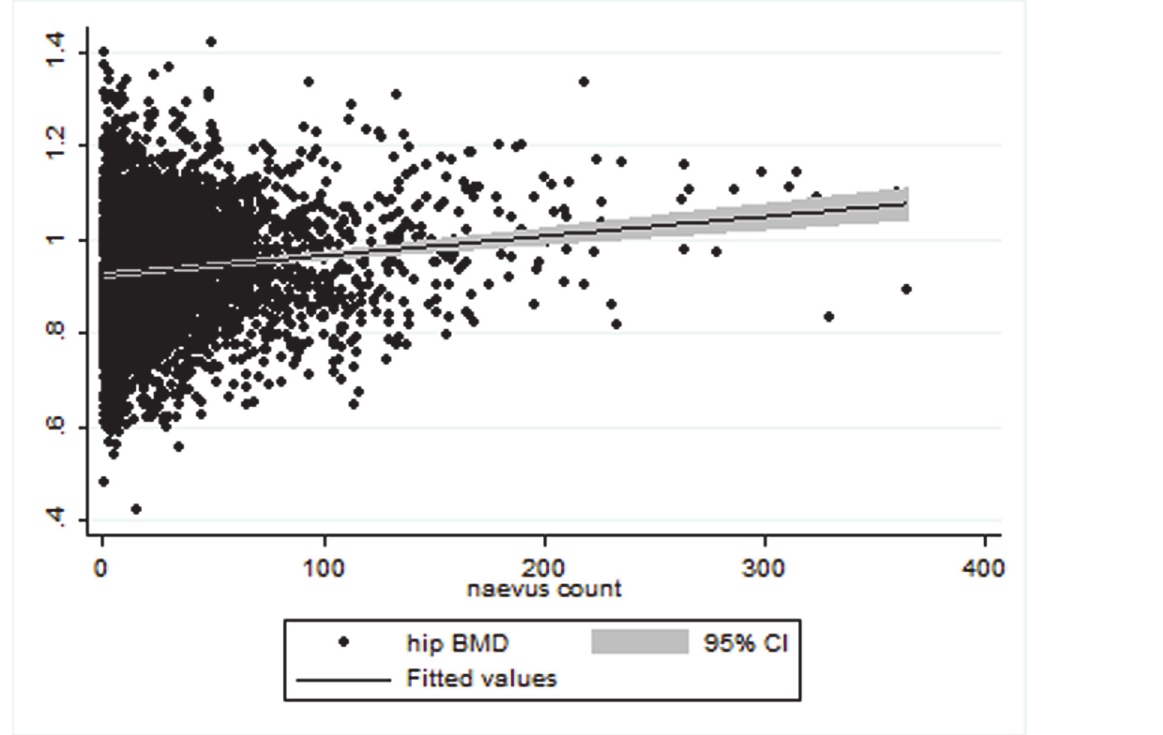
Figure 4. Scatter plot for hip BMD (Y axis) in association with naevus count (X axis).